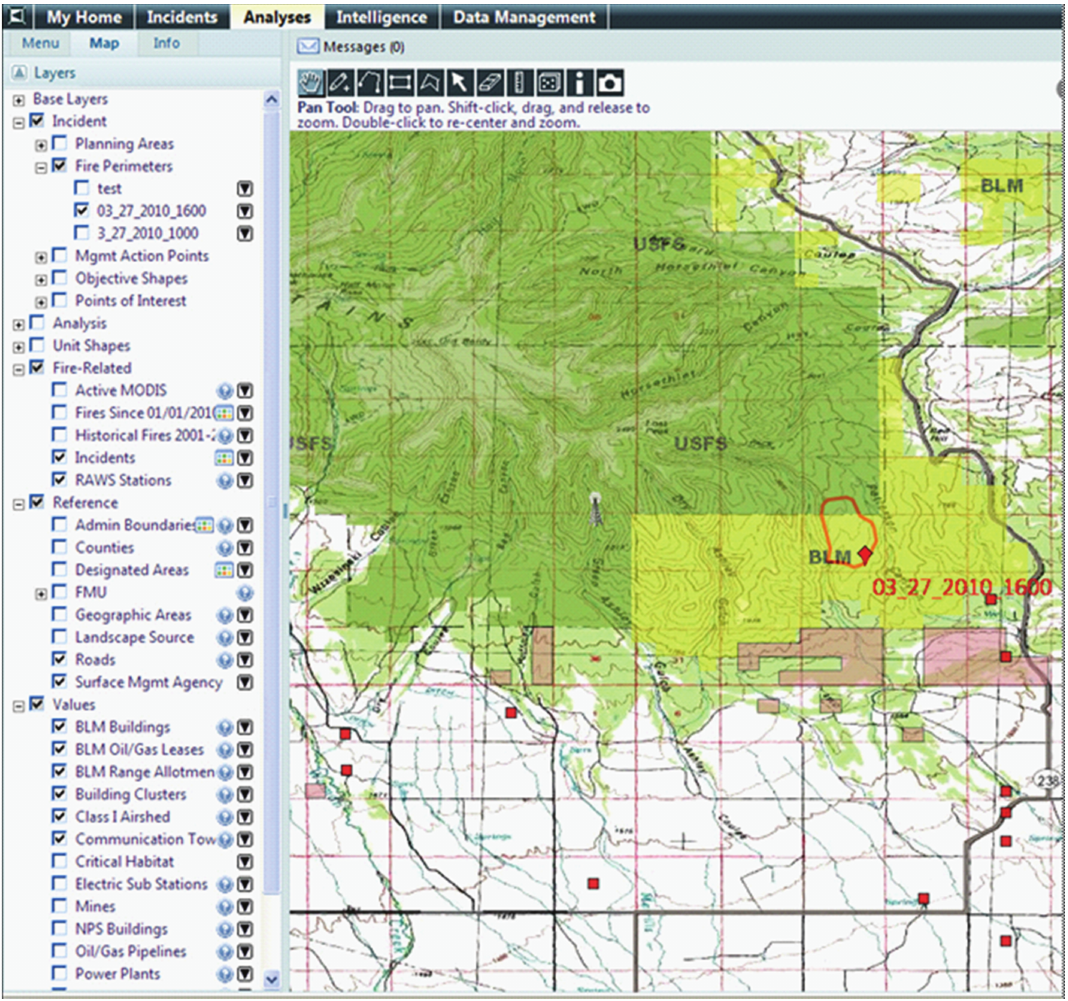
Figure 1: Geospatial data provided by WFDSS including information about fire location and size, reference information, and values. Geospatial layers with a check mark are viewable on the map. The red line is the fire perimeter from March 27, 2010 at 1600; small boxes represent Bureau of Land Management (BLM) buildings, USDA Forest Service (USFS) buildings, and building clusters; square polygons represent grazing areas for livestock (BLM range allotments). The BLM and USFS are the surface management agencies responsible for land management in their respective